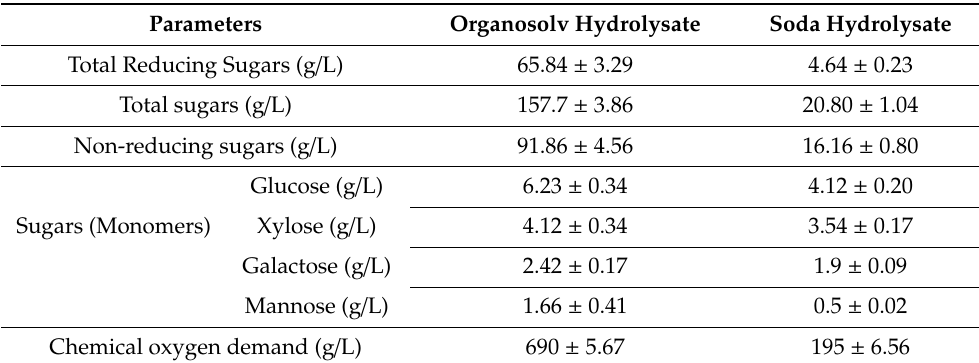
Table 3. Characterisation of corncob